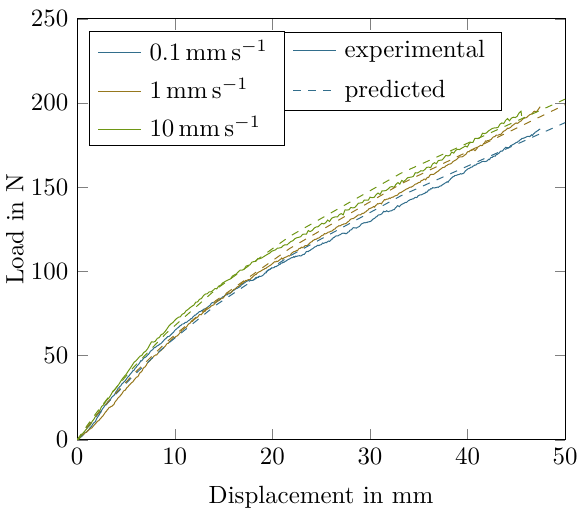
Figure 8. Experimental and predicted force- displacement diagram with the Mooney-Rivlin model.